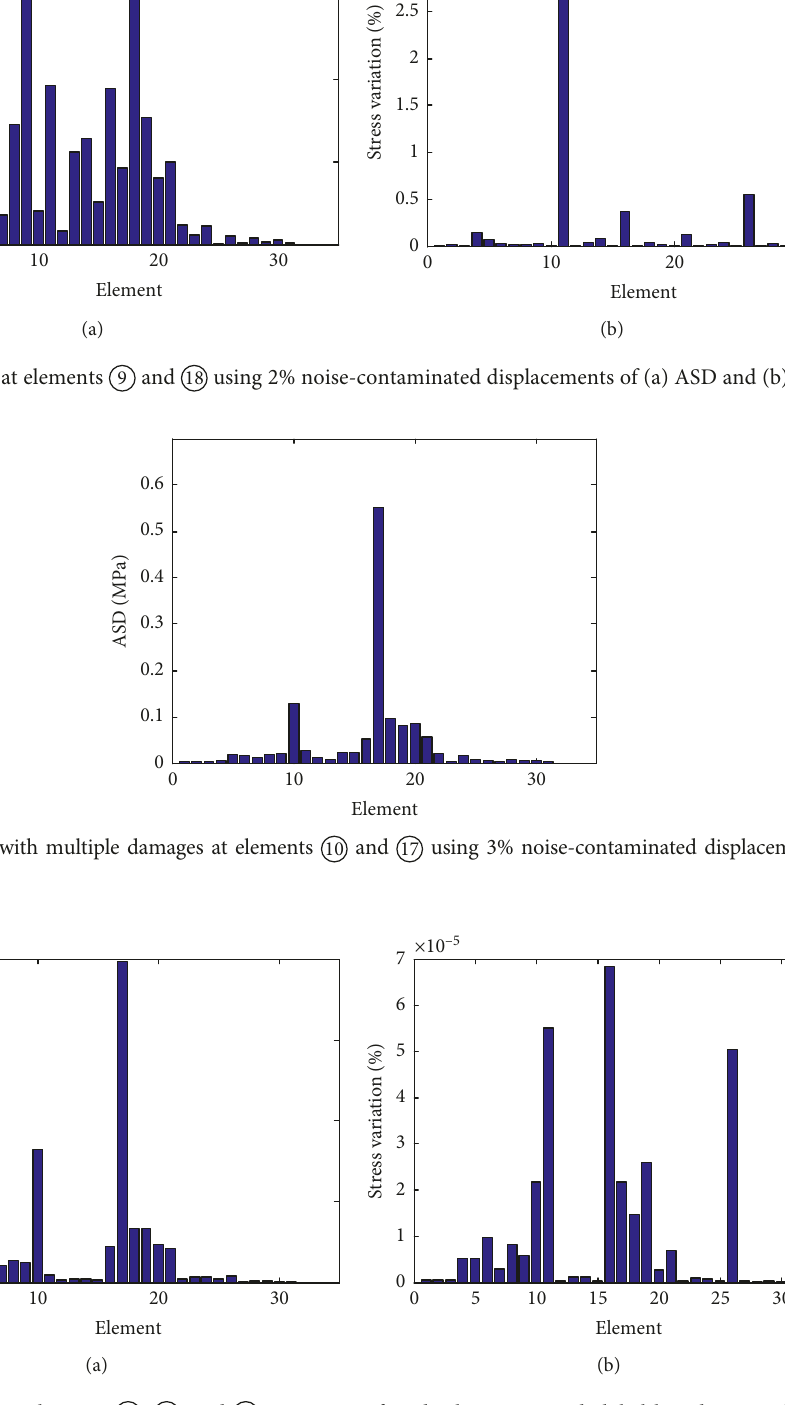
Figure 15: Multiple damages at elements 10 , 17 , and 26 using noise-free displacements and global-based approach of (a) ASD and (b) stress variation